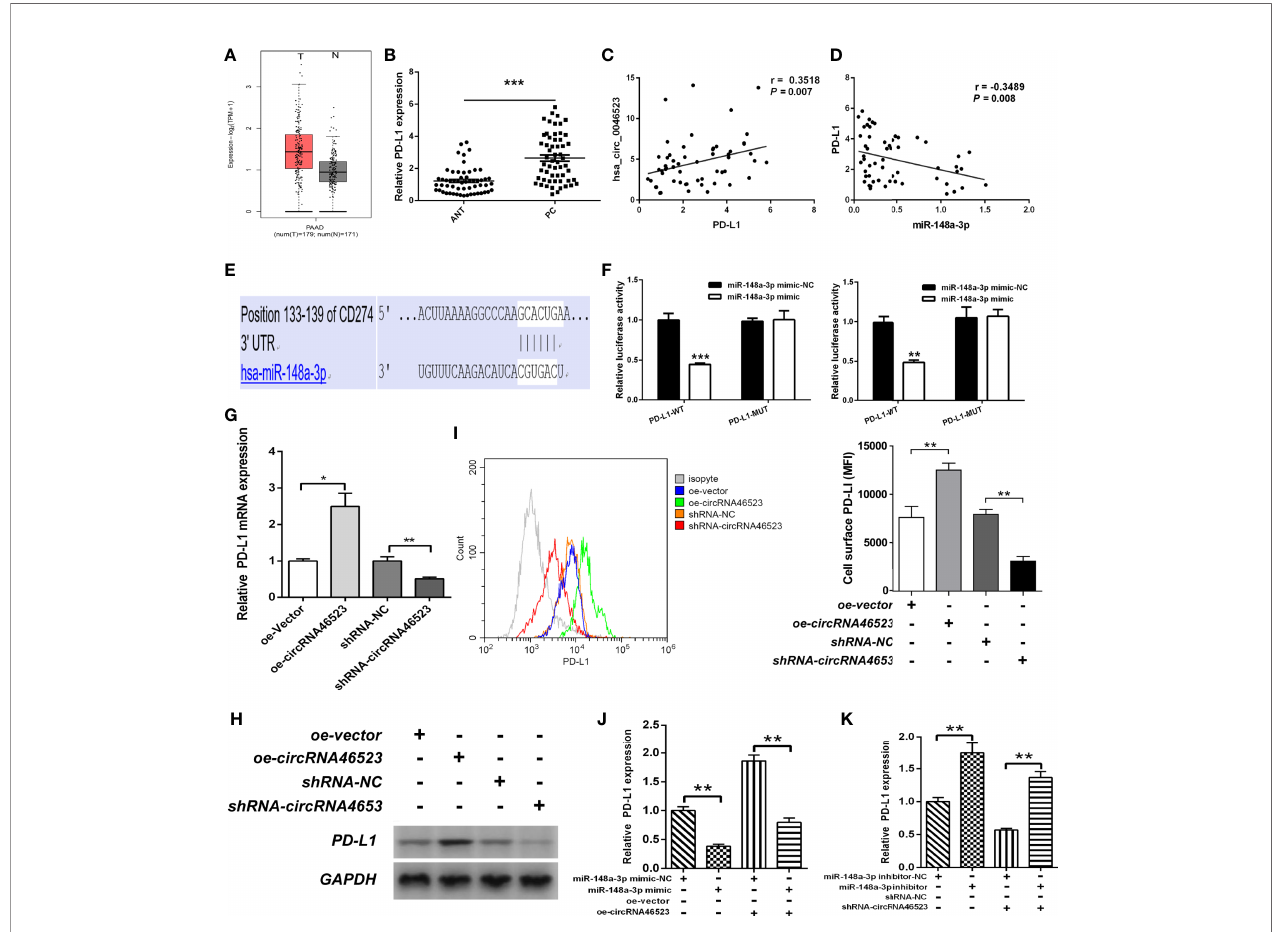
FIGURE 5 | Hsa_circ_0046523 regulated PD-L1 expression by sponging miR-148a-3p. (A) GEPIA database was used to analyze the expression of PD-L1 in PC tissues. (B) qRT-PCR analysis of the expression of PD-L1 in 57 pairs of PC and ANT specimens. (C, D) The expression level of PD-L1 is positively correlated with hsa_circ_0046523 (Pearson ’ s correlation analysis, r = 0.3111, P = 0.019), while negatively correlated with miR-148a-3p in PC tissues (Pearson ’ s correlation analysis, r = -0.3516, P = 0.007). (E) The targeted binding site of PD-L1 and miR-148a-3p. (F) Luciferase activities of PD-L1-3 ’ UTR-wt and PD-L1-3 ’ UTR-mut constructs when transfecting with miR-148a-3p mimic in PC cells. (G, H) qRT-PCR and WB analysis of PD-L1 expression in PC cells after hsa_circ_0046523 overexpression or knockdown. (I) Flow cytometry analysis of the membrane expression of PD-L1 in PC cells after hsa_circ_0046523 overexpression or knockdown. (J) qRT-PCR analysis the expression of PD-L1 in PC cells after upregulation of miR-148a-3p or combined with hsa_circ_0046523 overexpression. (K) qRT-PCR analysis the expression of PD-L1 in PC cells after down-regulation of miR-148a-3p or combined with hsa_circ_0046523 knockdown. Data were expressed as means ± SD of three independent experiments. * P < 0.05, ** P < 0.01, *** P <